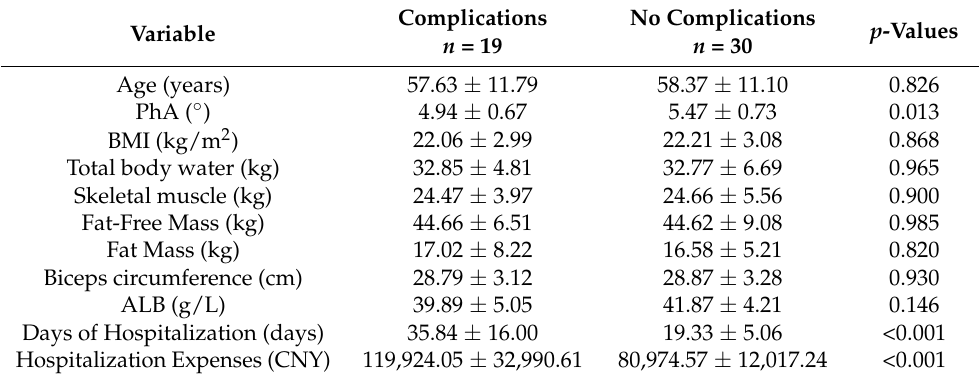
Table 5. The basic clinical data for participants with and without complications.